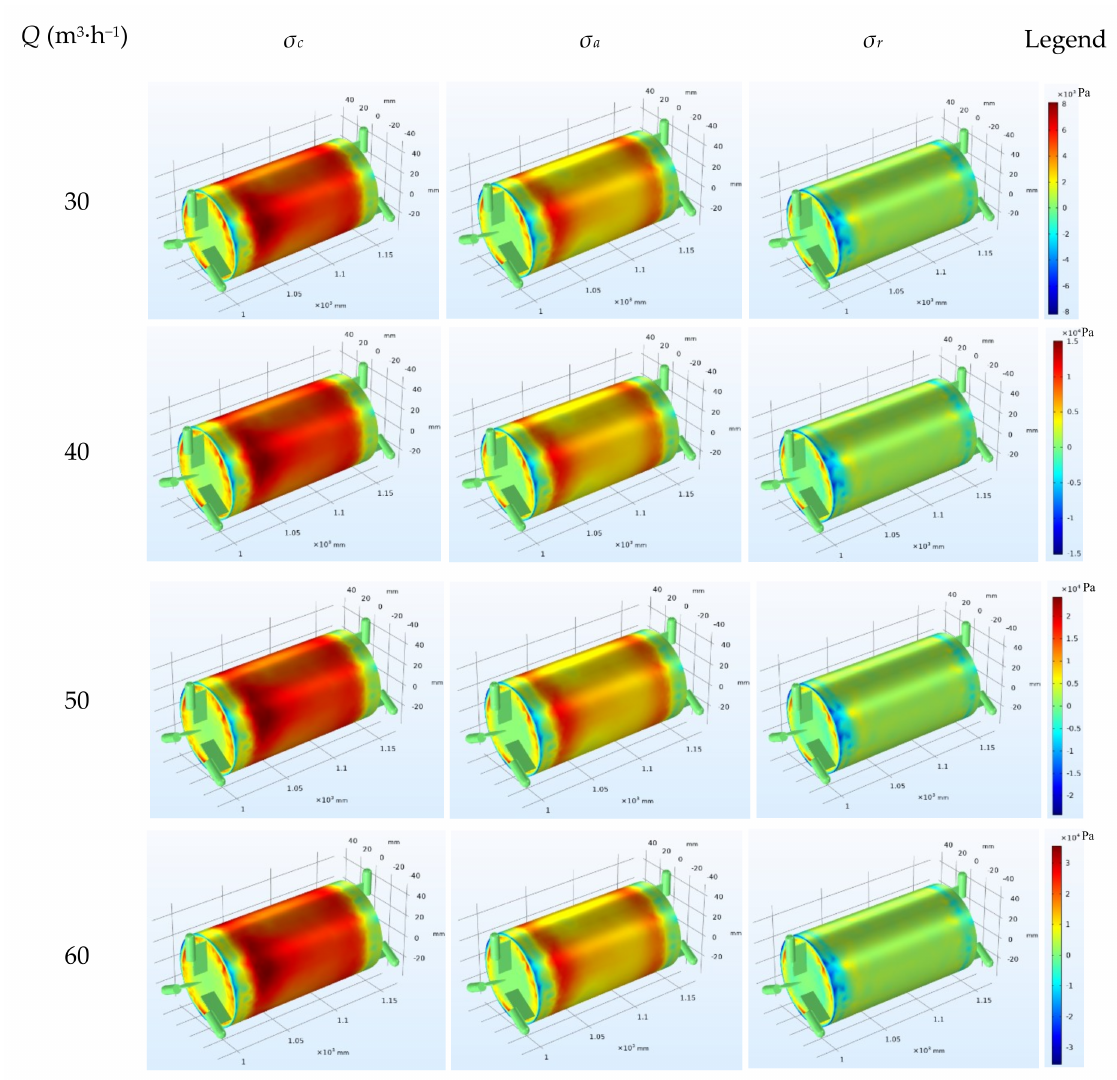
Figure 13. Principal stress distribution of the same piped carriage with a di ff erent discharge ( D c × L c = 80 mm × 150